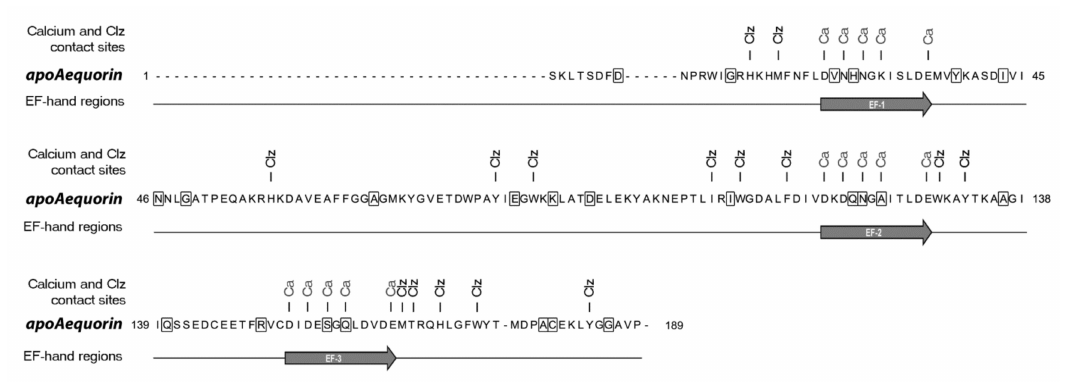
sensitivity. The apo-aequorin sequence from Aequorea victoria (PDB code: 1EJ3) is 198 amino acids long.